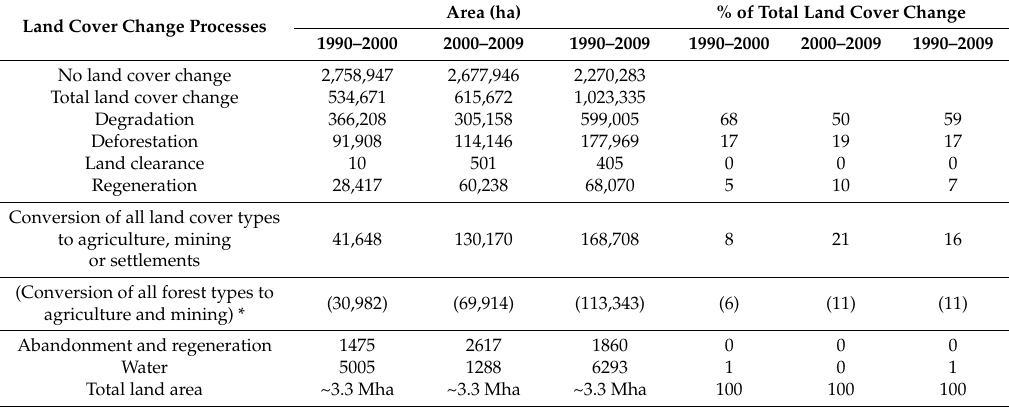
Figure 3. Quantification and schematic presentation of the land cover change processes and trajectories in the West Kutai and Mahakam Ulu districts based on the pixel-to-pixel cross tabulations of the land cover maps and the diagram resulting from the interviews. The boxes on the left indicate the naturally-occurring land cover types and the boxes on the right the agricultural land uses, mining sites and settlements. Each arrow shows the change from one land cover type to another that occurred from 1990–2000 ( A ) and from 2000–2009 ( B ). One arrow thus shows a one-step trajectory. The thickness of each arrow (see legend) indicates the area of change for each of the trajectories within the given time period. The land cover changes identified for the entire period of 1990–2009 are shown in Figure S5 (in the Supplementary Materials). Table 1. Quantified land cover change processes based on remote sensing data [43] that occurred in the periods 1990–2000, 2000–2009 and 1990–2009. See Supplementary Materials S2 for a definition of the land cover change processes.